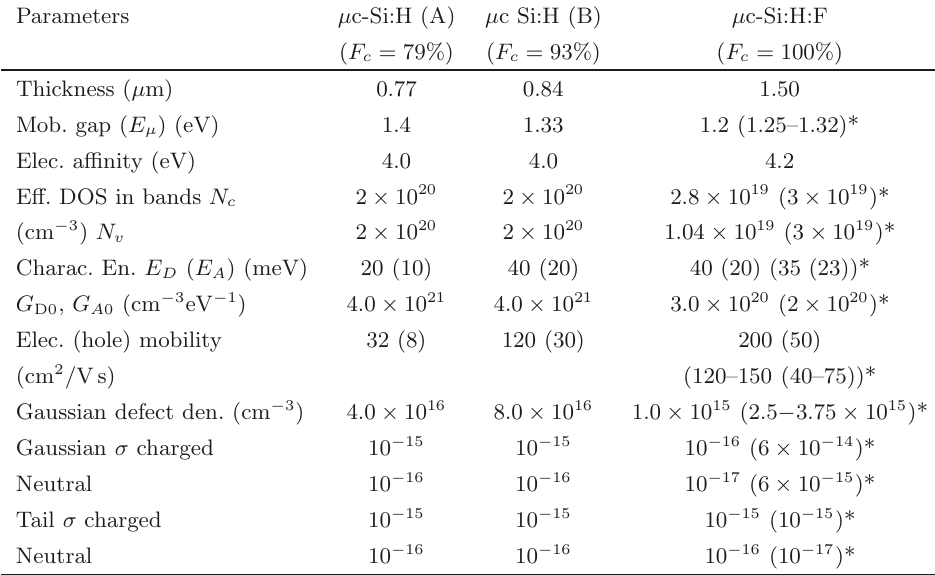
Table 2. Parameters that characterize intrinsic μ c-Si:H of different degree of crystallinity (as extracted by modeling). The quantities in brackets marked with asterisks in the column of parameters of μ c-Si:H:F correspond to the values extracted by modeling similar μ c-Si:H samples (refs TSF, JAP of